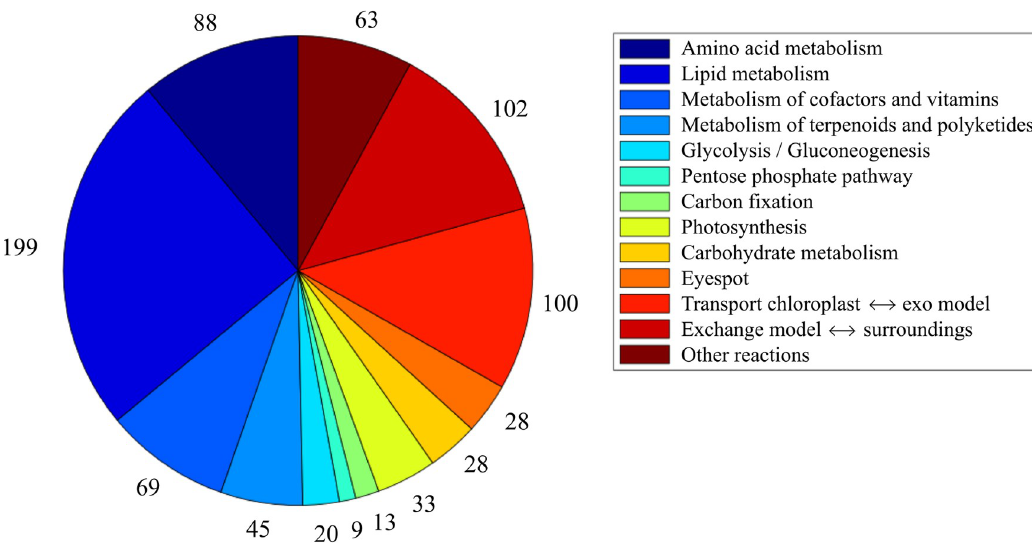
Fig 1. The number of chloroplast reactions affiliated with each major subsystem group.